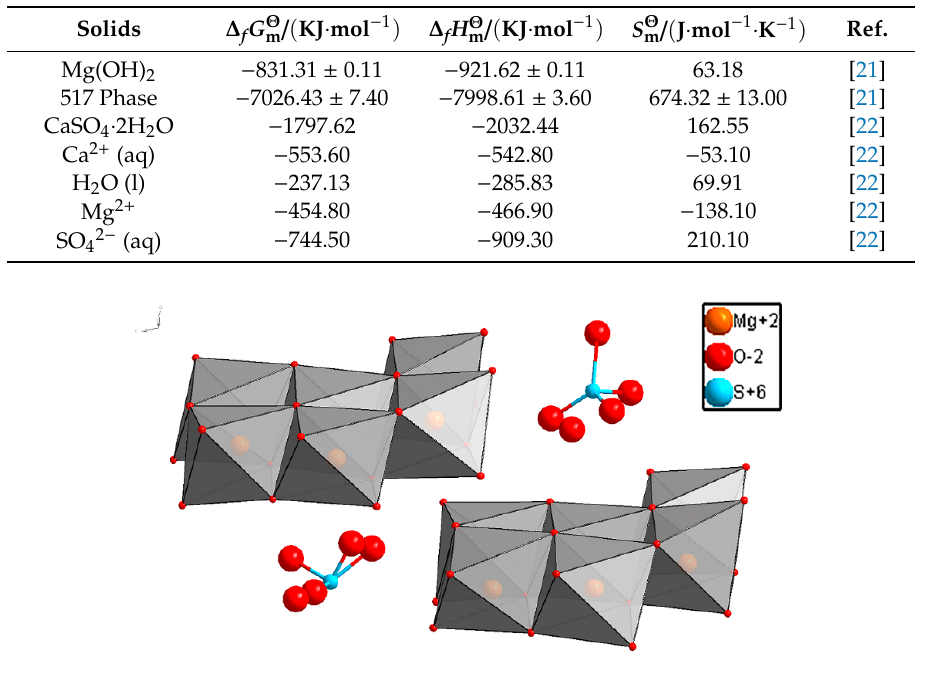
Figure 11. Crystal structure of 517 phase.